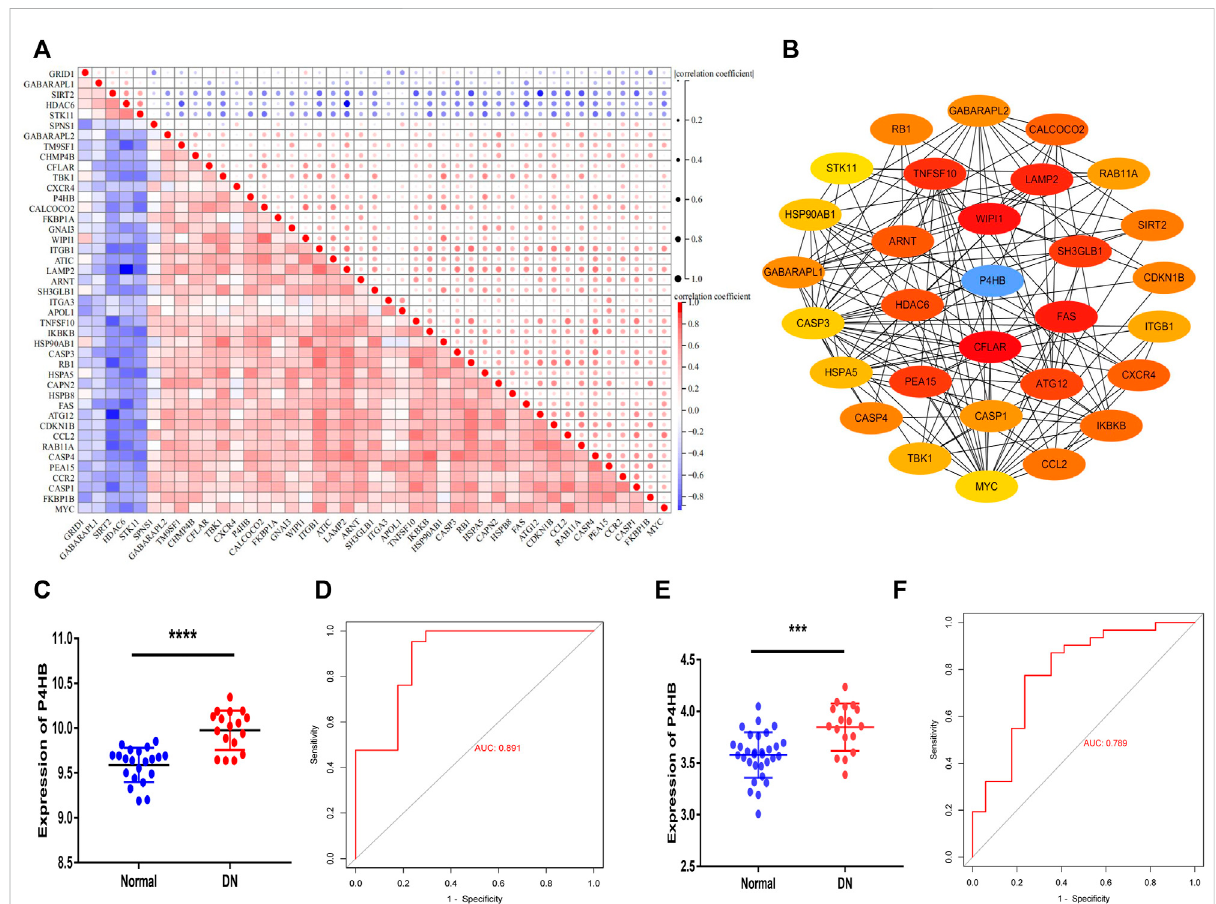
FIGURE 4 Identifying P4HB as a hub autophagy-related gene in DN and validating in the GSE104954 database and ERCB cohort. (A) Spearman ’ s correlationanalysisofthe43DEARGs. (B) Top30hubDEARGsidenti fi ed via thePPInetwork. (C,D) Validationof P4HB inGSE104954. (C) Signi fi cantly upregulated expression of P4HB in DN patients (n = 17) compared to healthy samples (n = 21) ( p < 0.0001) (D) ROC curve of P4HB expression in DN (AUC = 89.1%). (E, F) Validation of P4HB in the ERCB cohort. (E) Signi fi cantly upregulated expression of P4HB in DN patients (n = 17) compared to healthy samples (n = 31) ( p < 0.0001). (F) ROC curve of P4HB expression in DN (AUC = 78.9%). * p < 0.05, ** p < 0.01, *** p < 0.001, and **** p < 0.0001. DEARG, differentially expressed autophagy-related gene; DN, diabetic nephropathy; PPI, protein – protein Interaction; ROC, receiver operating curve; AUC, area under the curve; ERCB: European Renal cDNA